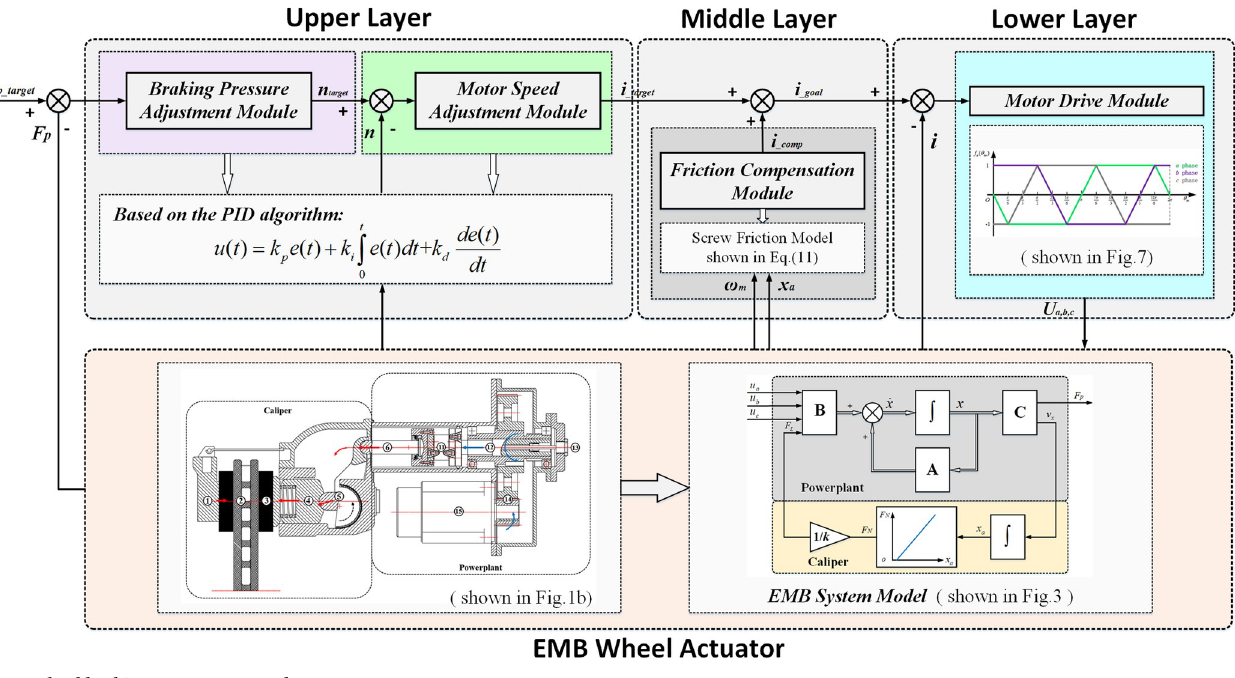
Fig 6. Wheel braking pressure control